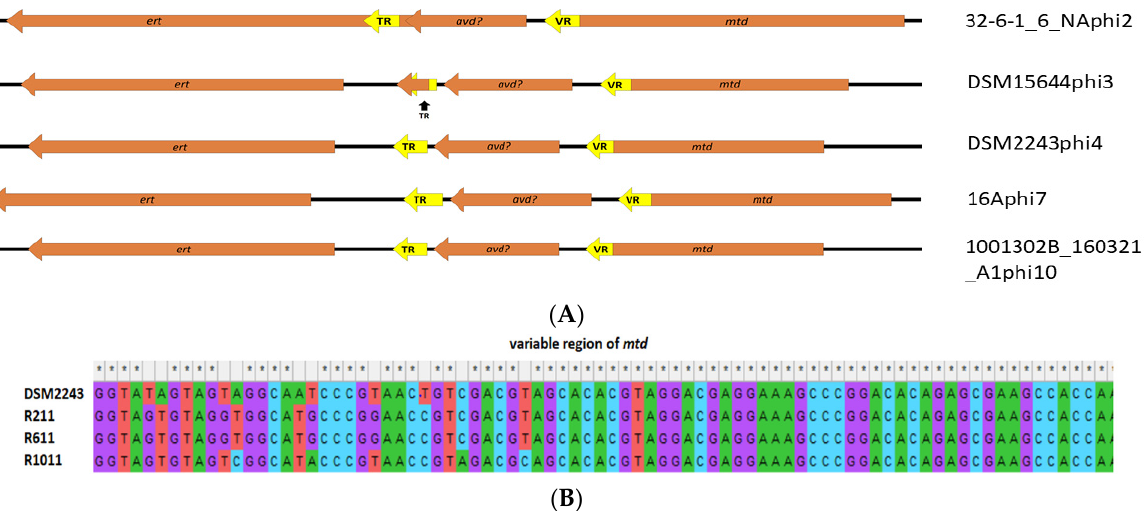
Figure 6. ( A ) Locus map of the architecture of the DGR element found among different prophage types of E. lenta , showing genes (arrows in orange) and sequence repeat regions (arrows/arrow segments in yellow) relative to the direction of transcription and labelled accordingly to predicted function. ( B ) Alignment of a VR segment of the mtd gene forming part of the DGR element of a clade 4 prophage associated with strain DSM2243, to isolates of the bacterium (R211, R611 and R1011) grown after fermentation in a chemostat (24 h as batch, then 72 h as continuous) illustrating locations of nucleotide substitutions.